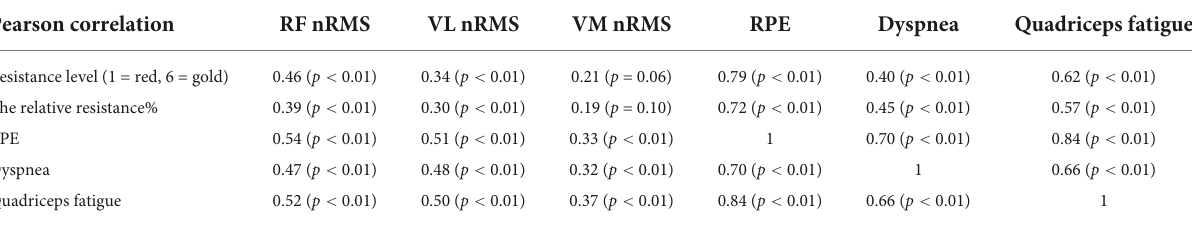
TABLE 5 Association between outcome